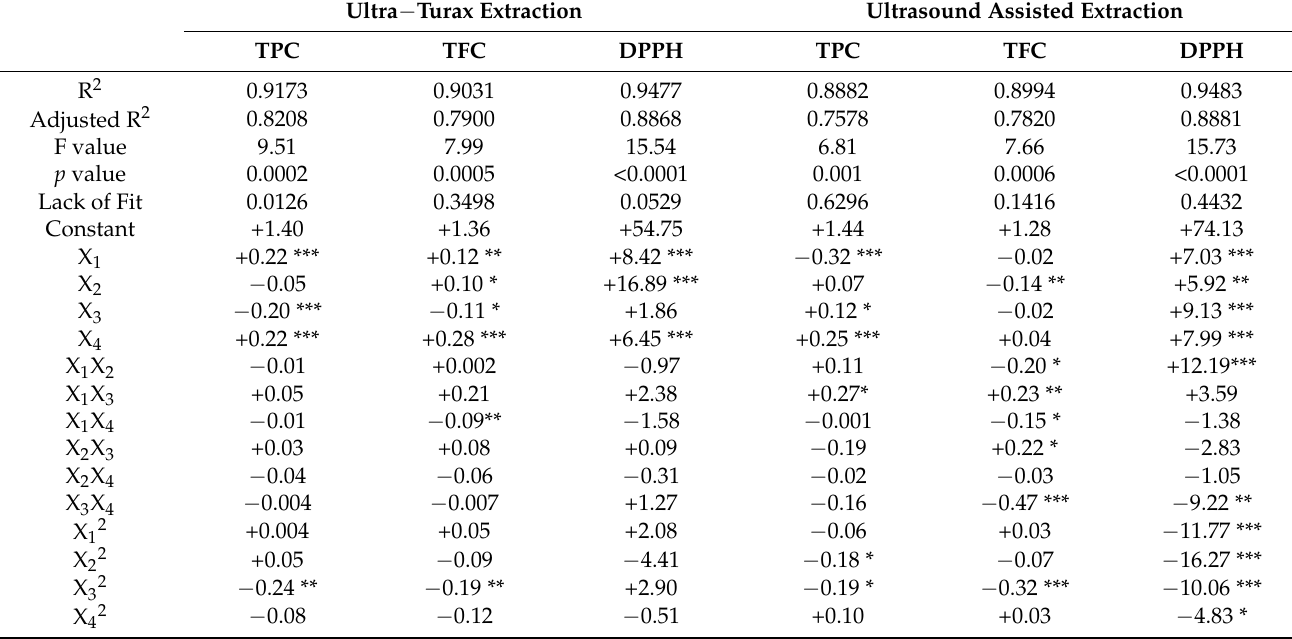
Table 2. ANOVA results for model fitting.